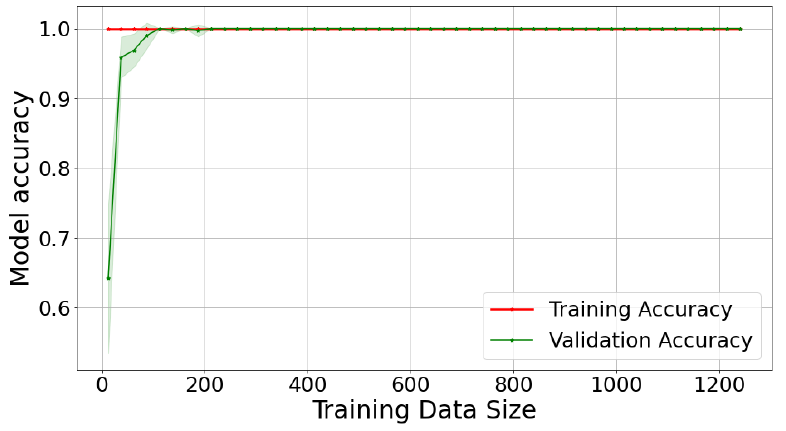
Figure 16. Learning Curve from P1.